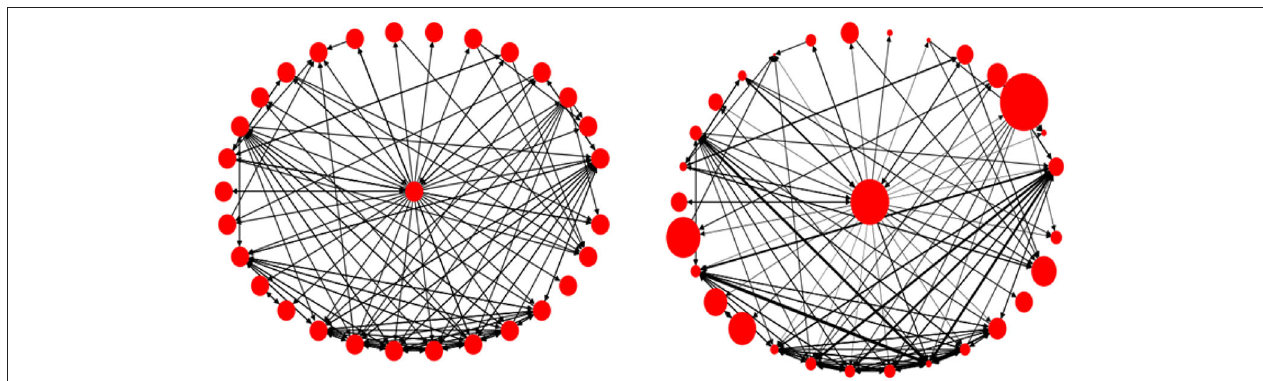
FIGURE 7 | An ego network, without assigning weights ( Left ), and with weights ( Right ).